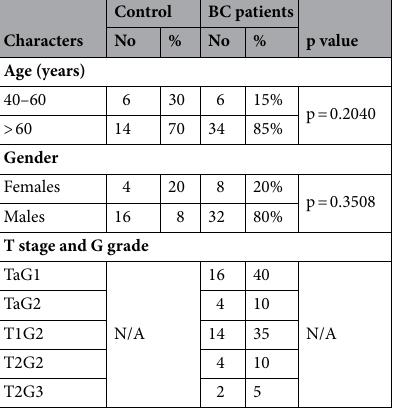
Table 1. Demographic and clinical characteristics of patients and control subjects. The p-values were calculated using the Student’s